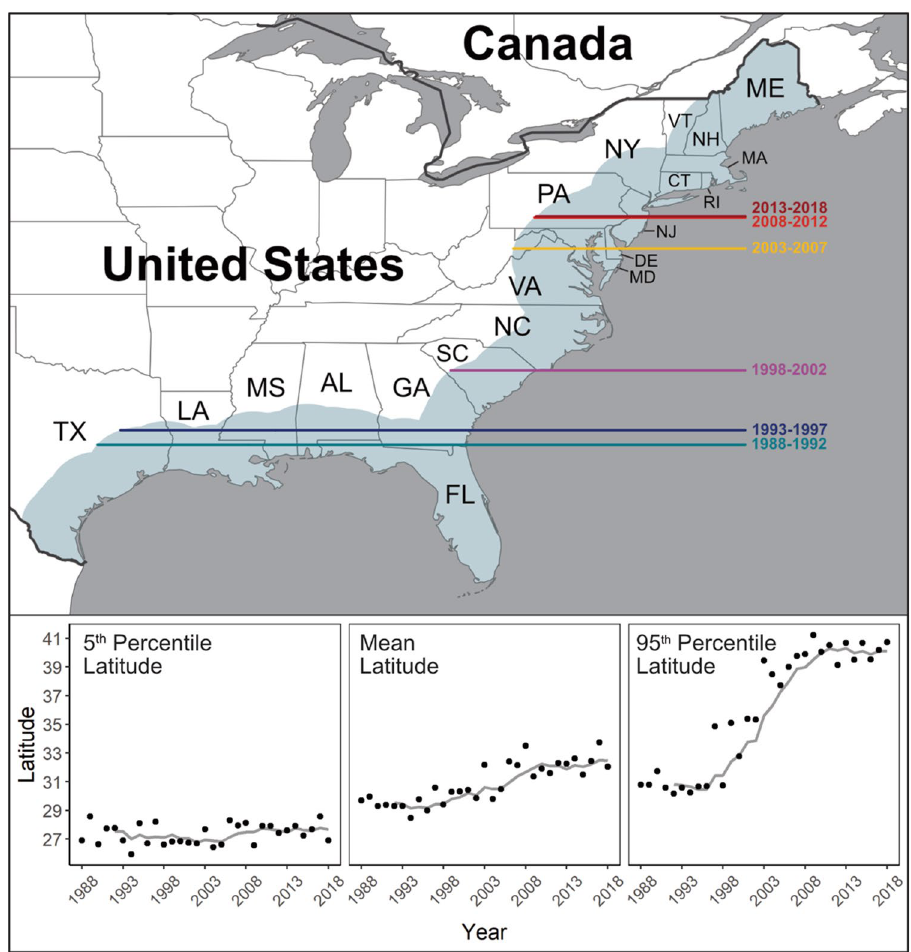
Figure 2. Latitudinal shifts by year of confirmed non-foodborne V. vulnificus infections in the USA reported to the Cholera and Other Vibrio Illness Surveillance (COVIS) between 1988 and 2018. The 95th latitude percentile in 5-year bands is presented in the upper panel. The lower panel presents the 5th percentile, mean and 95th latitude percentile for individual years alongside 5-year rolling